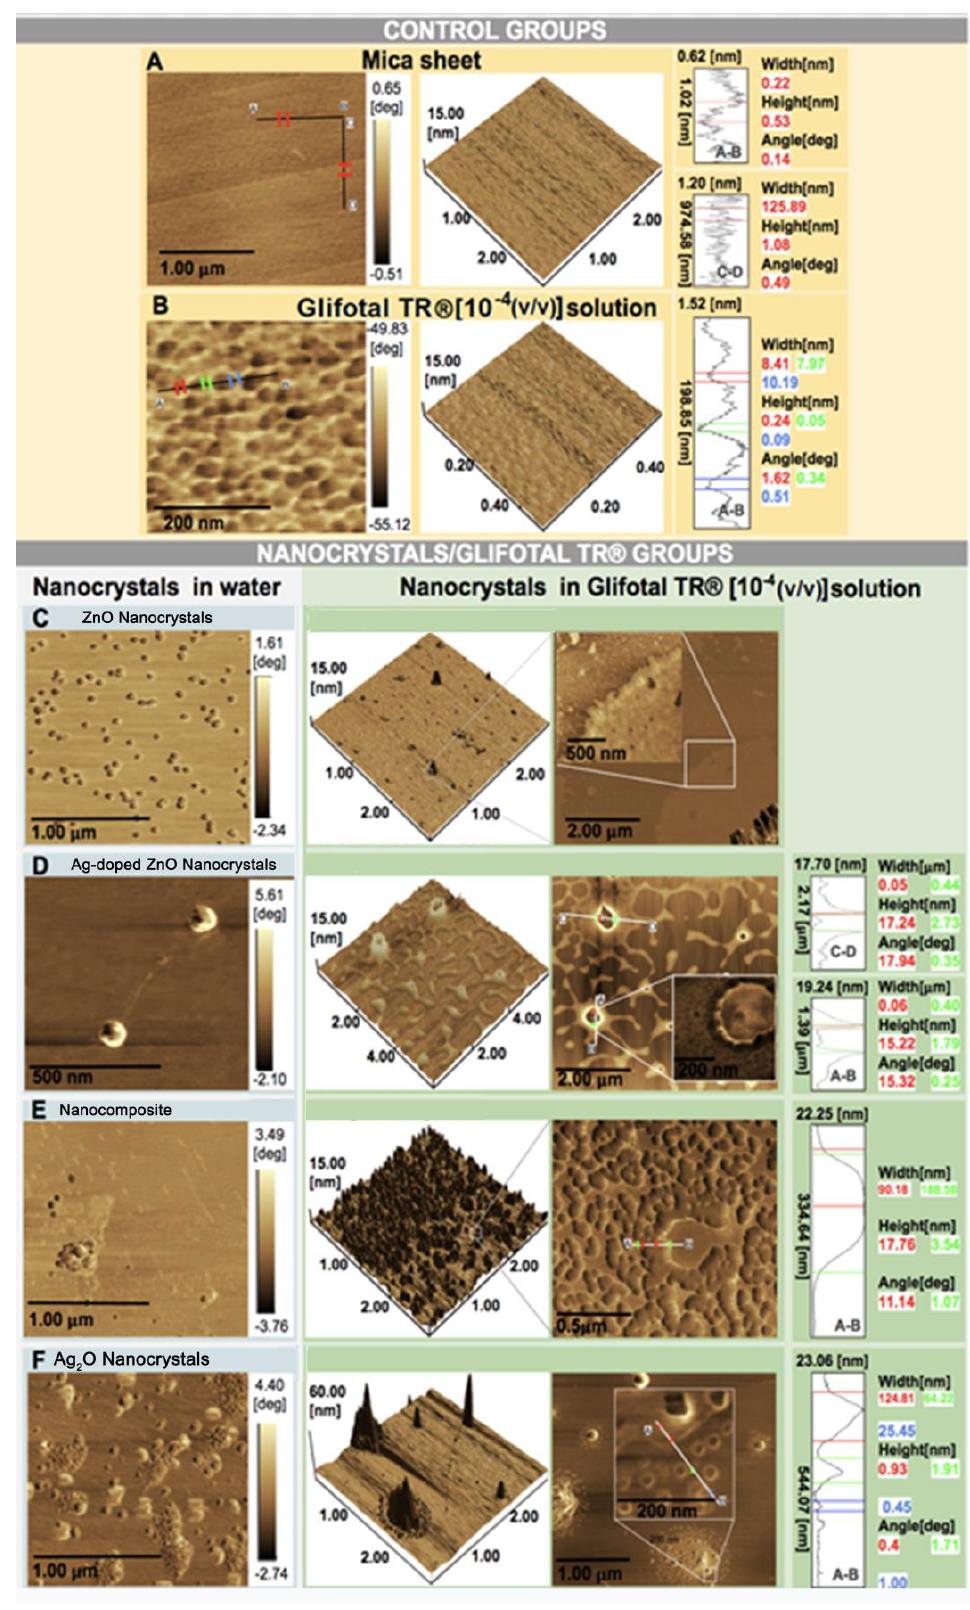
Figure 5. Atomic force microscopy (AFM) images of the control groups (mica and GLIFOTAL TR) and the nanocrystal/GLIFOTAL TR groups (ZnO, Ag-doped ZnO, nanocomposite, and Ag 2 O) in 10 − 4 ( v / v ).